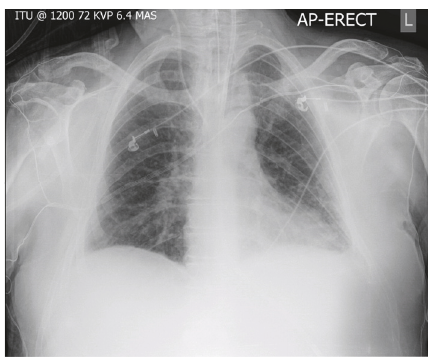
Figure 2: Repeat CXR on ICU day 11; ongoing hypoxia despite suc- cessful diuresis.